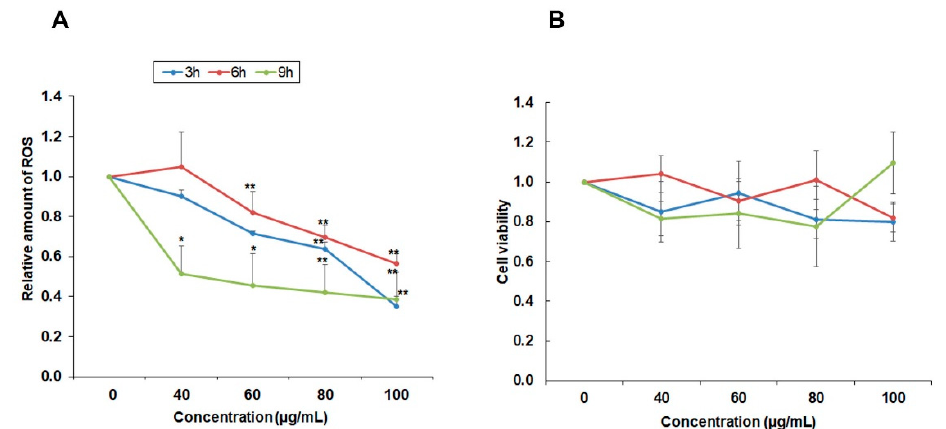
Figure 4. Effect of YLE on ROS formation of HepG2 cells. ( A ) Antioxidant effect of YLE on HepG2 cells after 3 h, 6 h, and 9 h. Data are expressed as averages ± S.D ( n = 3); * p < 0.05, ** p < 0.01 vs. control group. ( B ) Effect of YLE on cell viability. Data indicated no specific change between treatment groups and the control group after indicated times (3 h, 6 h, 9 h).